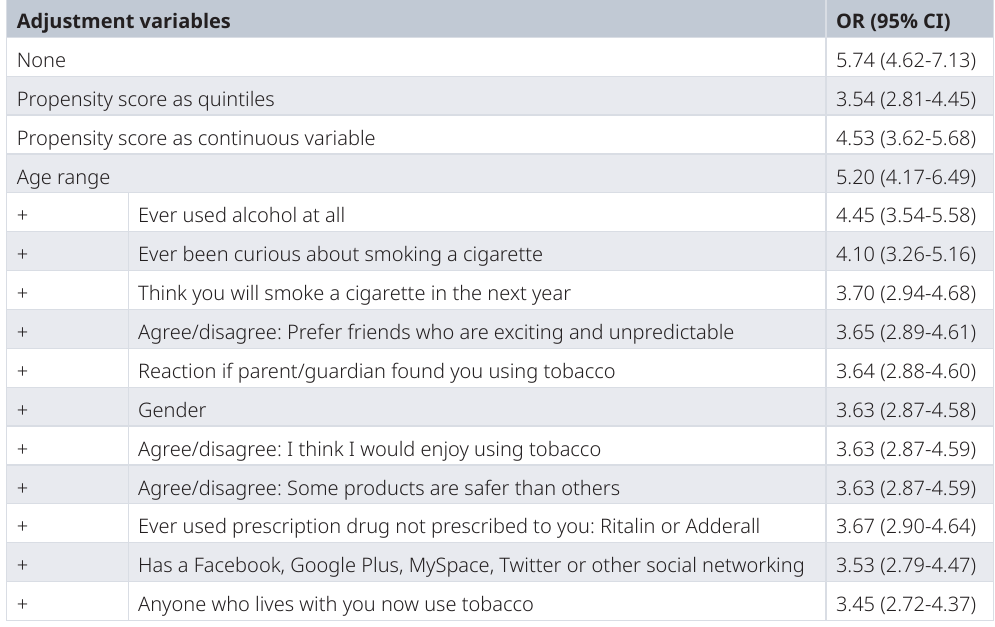
Table 3. Relating Wave 3 ever smoking to Wave 2 ever e-product use (Main analysis